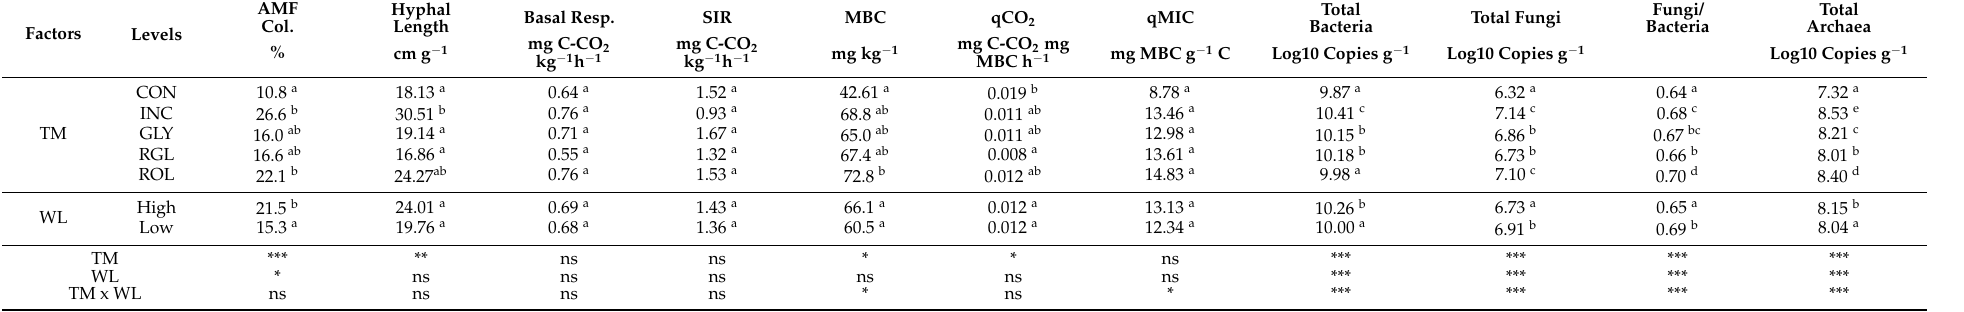
Table 2. Soil microbial variables as affected by the termination method (TM) and water level (WL) at 57 DAS